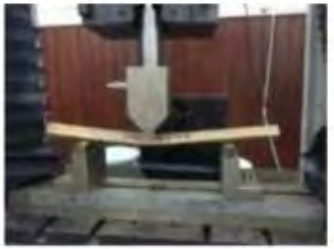
Figure 33. The Bending Procedures in the testing machine for span 280 mm (Author’s own, n.d.)